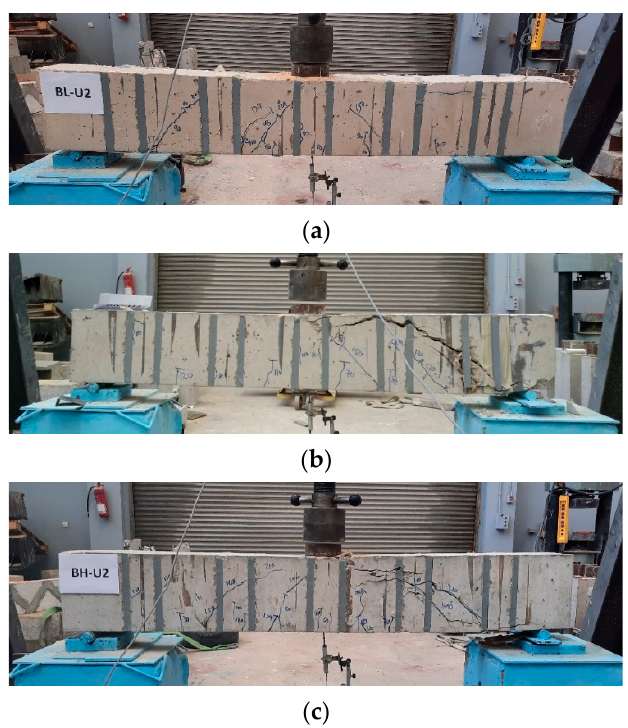
Figure 11. Failure modes of beams with two unaligned NSM ‐ CFRP strips: ( a ) BL ‐ U2, ( b ) BM ‐ U2, and ( c ) BH ‐ U2.